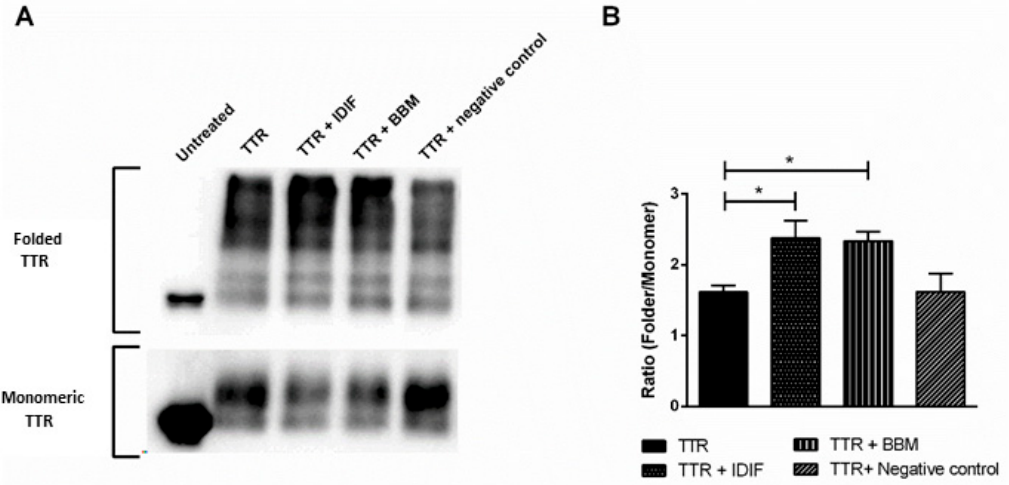
Figure 2. TTR resistance to urea denaturation. ( A ) TTR, alone or pre-incubated with di ff erent compounds, was subjected to urea denaturation, as described, and the generated species were detected by western blot. Incubation with iododiflunisal (IDIF) and benzbromarone (BBM) resulted in increased folded TTR, as compared to the negative control and TTR alone. ( B ) Quantification of results from three independent experiments. Error bars represent SEM. * p < 0.05.